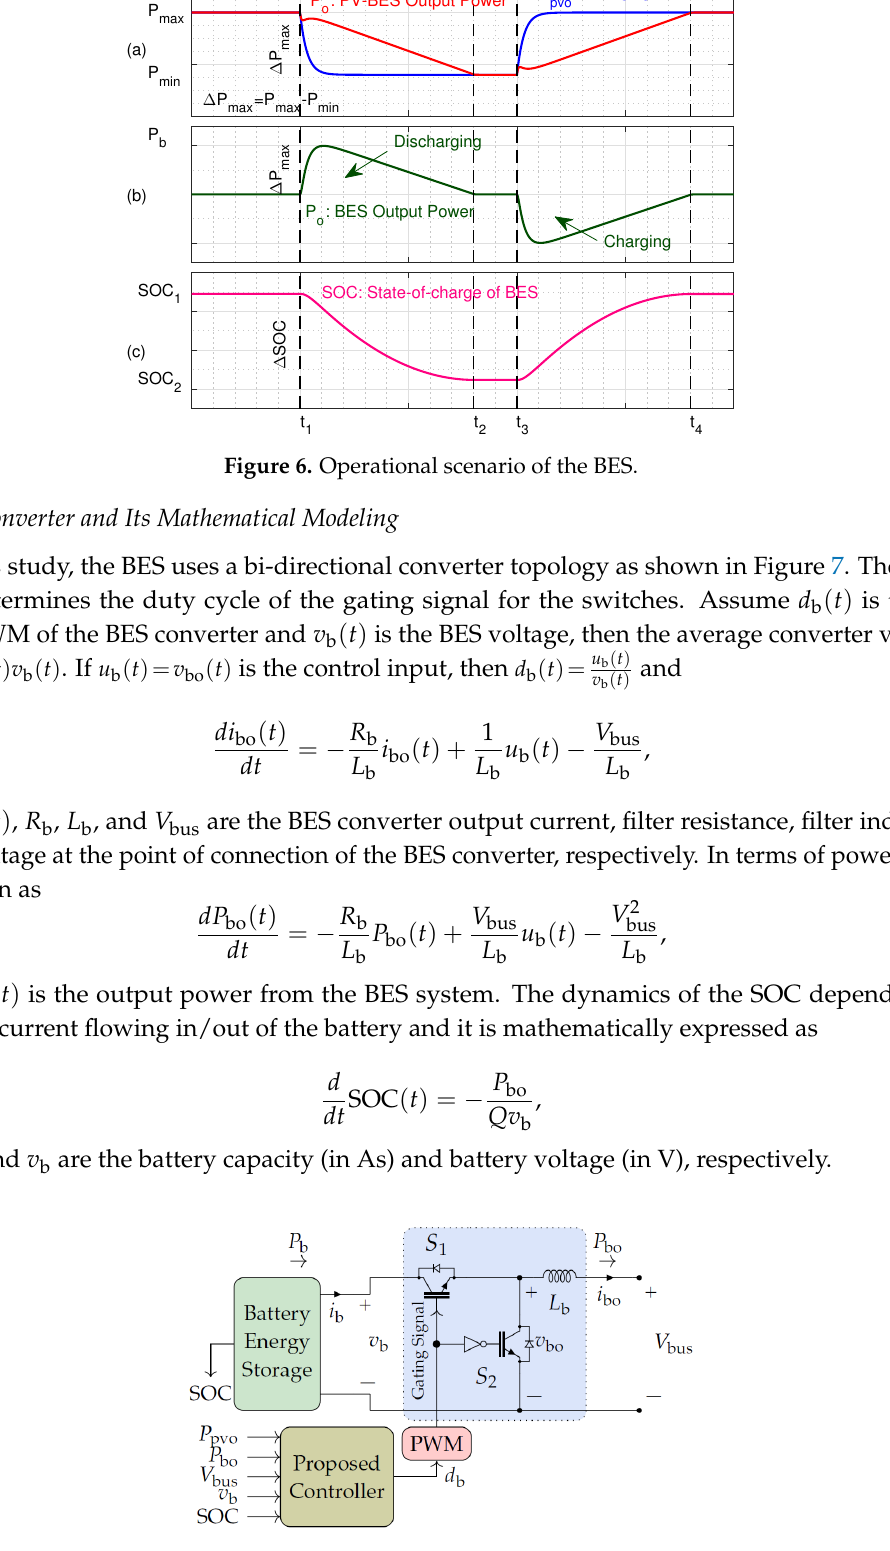
Figure 7. BES converter